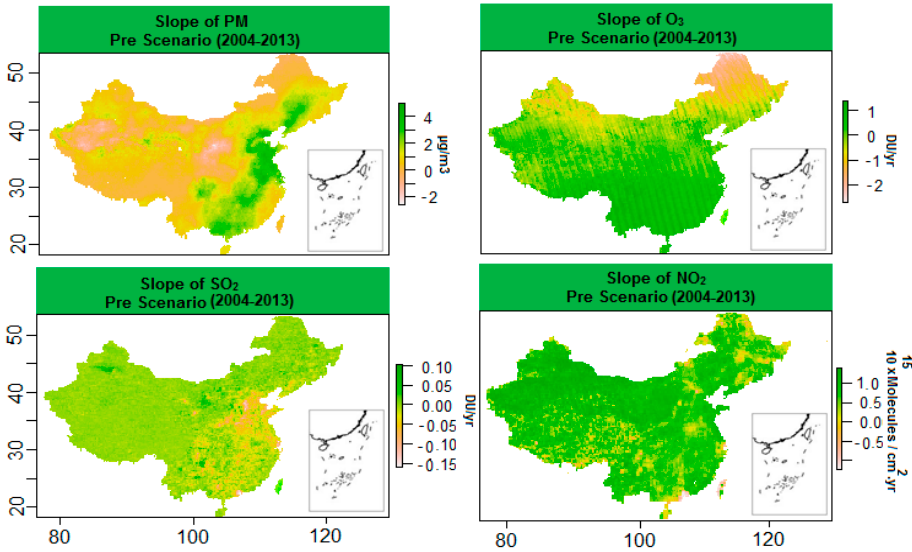
Figure 4. Slope of air pollutants for the pre-scenario (2004–2013).